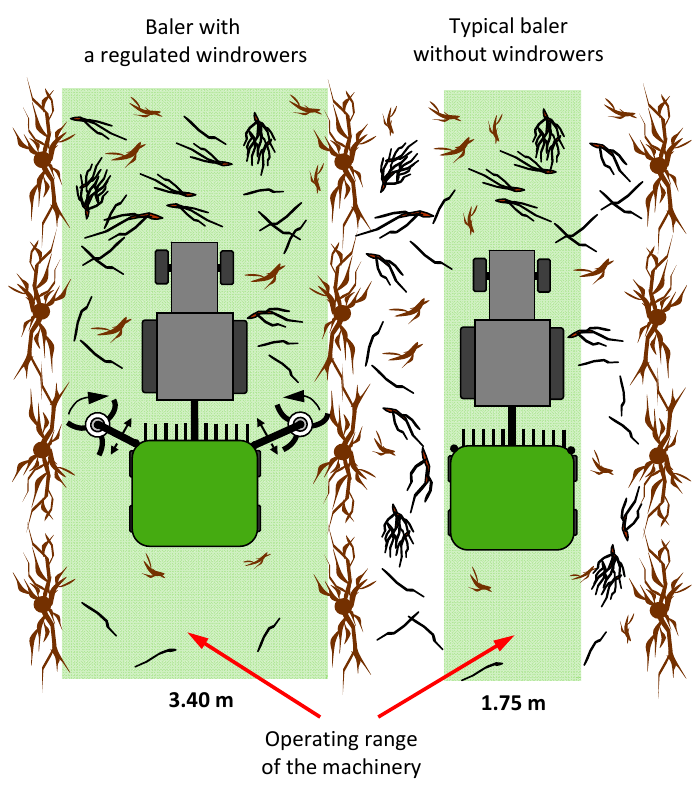
Figure 2. Operating range of the baler machinery (PRB 1.75) in the apple orchard.